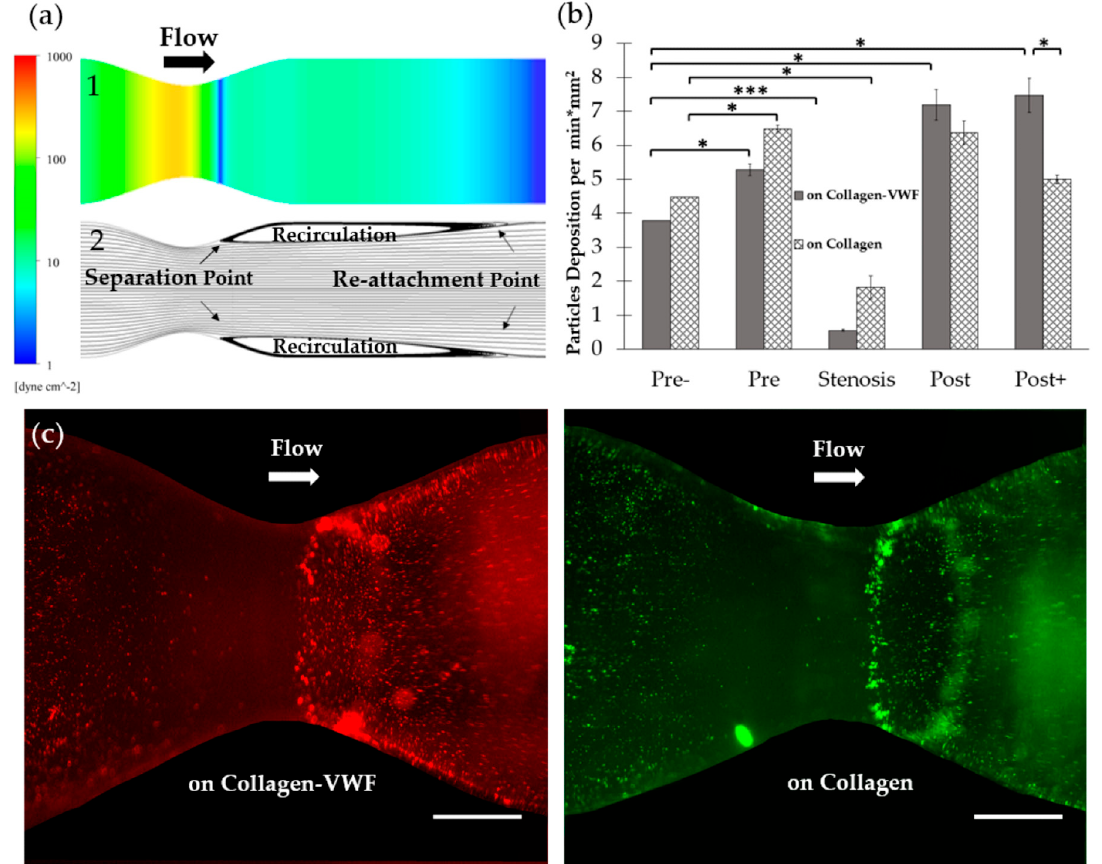
Figure 5. Spatial distribution of A1-NPs in collagen-VWF vs. collagen-coated 60% stenosis model. ( a ) Computational Fluid Dynamics (CFD) of: (1) Shear stress simulation of 60% stenotic model (note: color bar is in log-scale). (2) Streamlines simulation. ( b ) A1-NPs deposition as a function of model’s coating. ( c ) Representative fluorescent microscopy image of A1-NPs spatial deposition in the 60% stenosis model. Left: in collagen-VWF-coated model (red), Right: in a collagen-coated model (green). Scale: 1 cm.